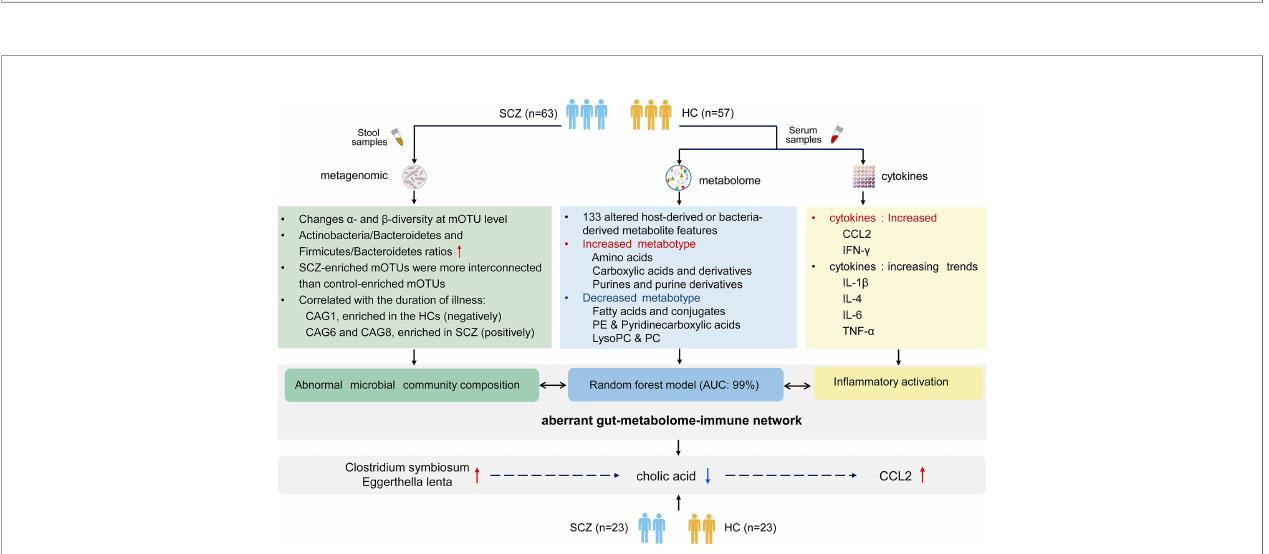
FIGURE 6 | The summary of gut microbiota composition, metabolism and cytokines analysis between schizophrenia and healthy control.